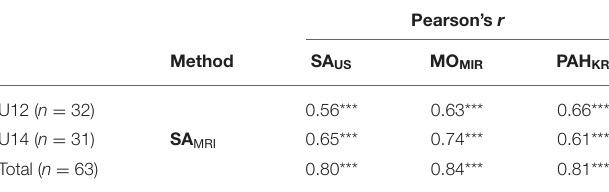
TABLE 2 | Correlation analyses between SA MRI and alternative diagnostics for the total sample and each age class